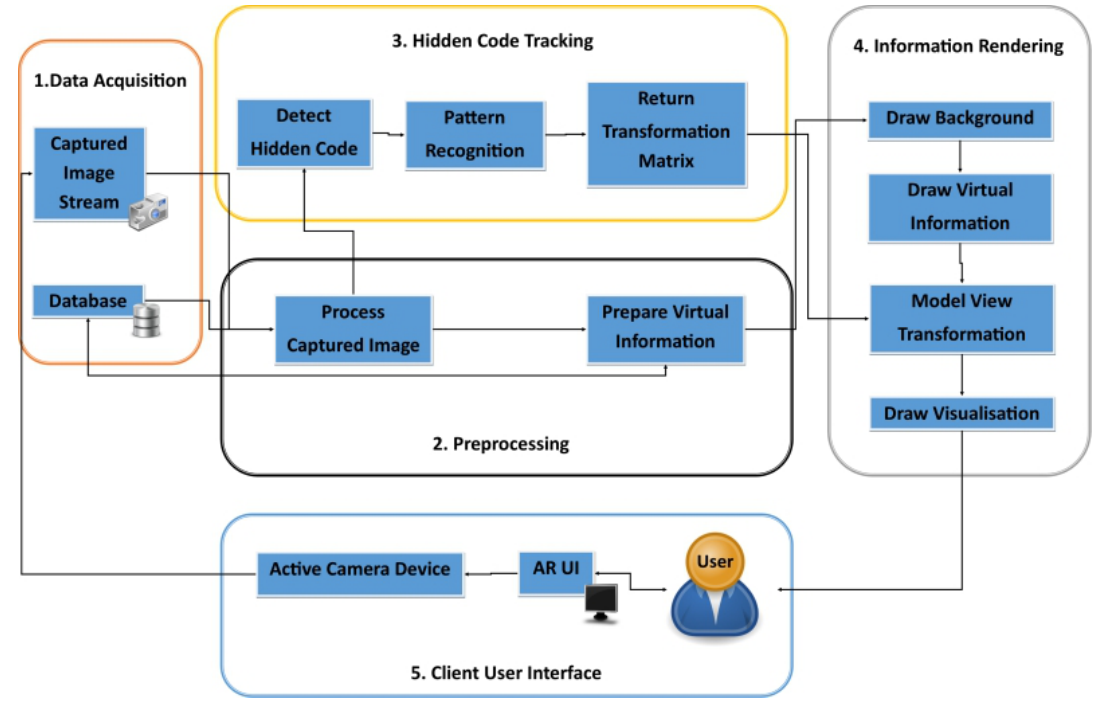
Figure 10. Design of our system architecture.